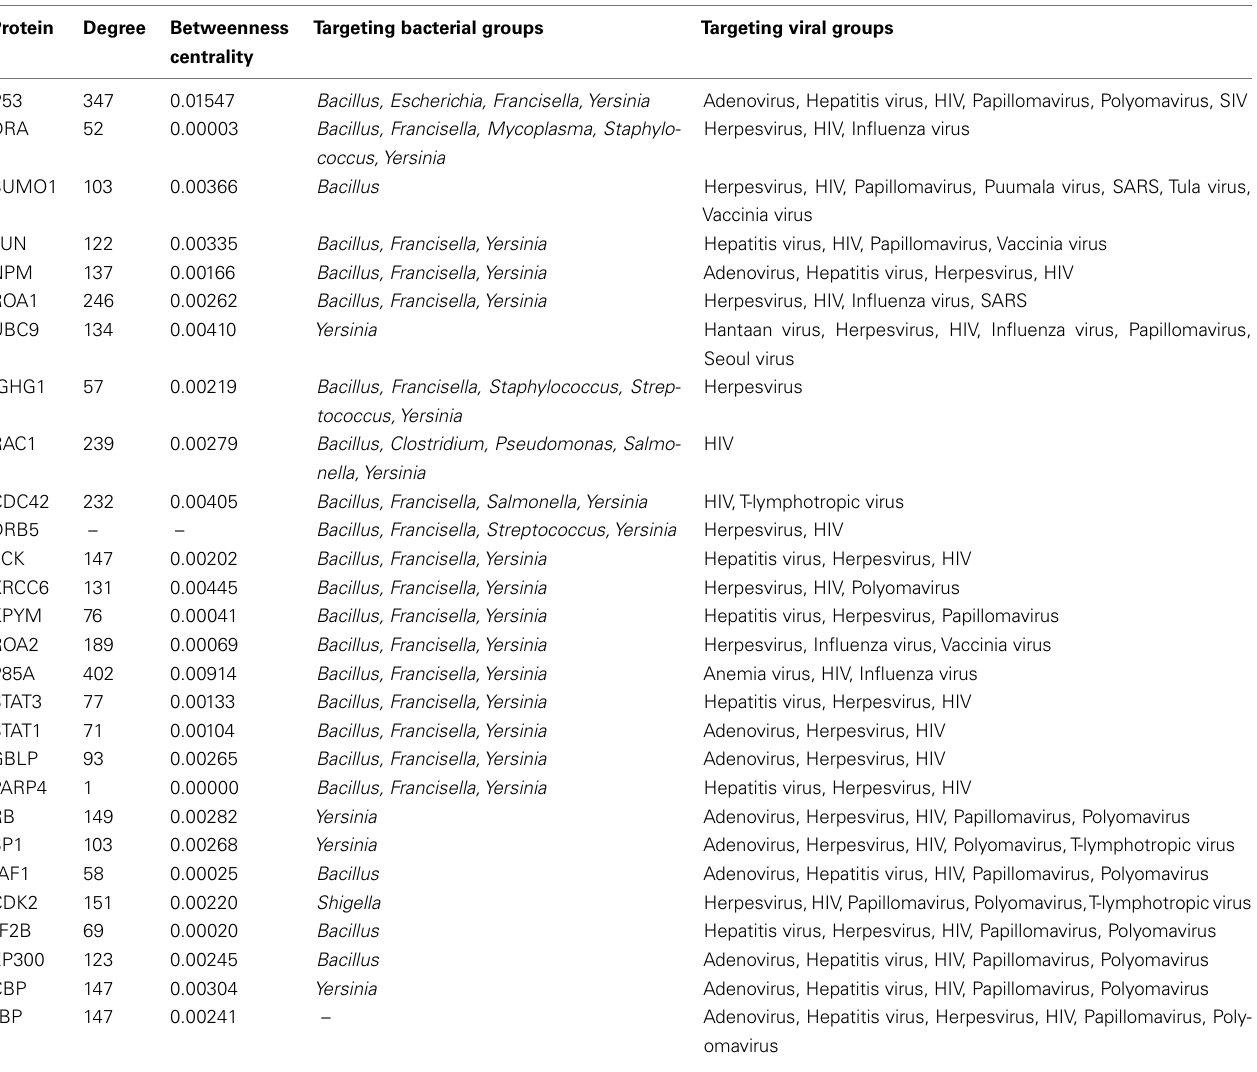
Table 2 | Highly targeted human